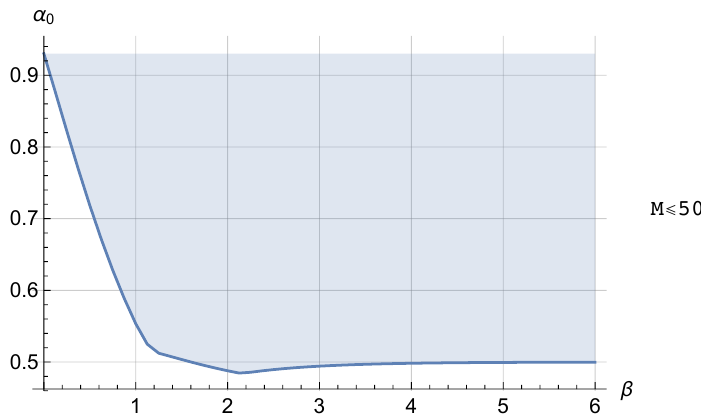
Figure 4 . Same as the plot of (cid:12)gure 3 projected on the ( (cid:12); (cid:11) 0 ) plane. Shaded region corresponds to positive residues.